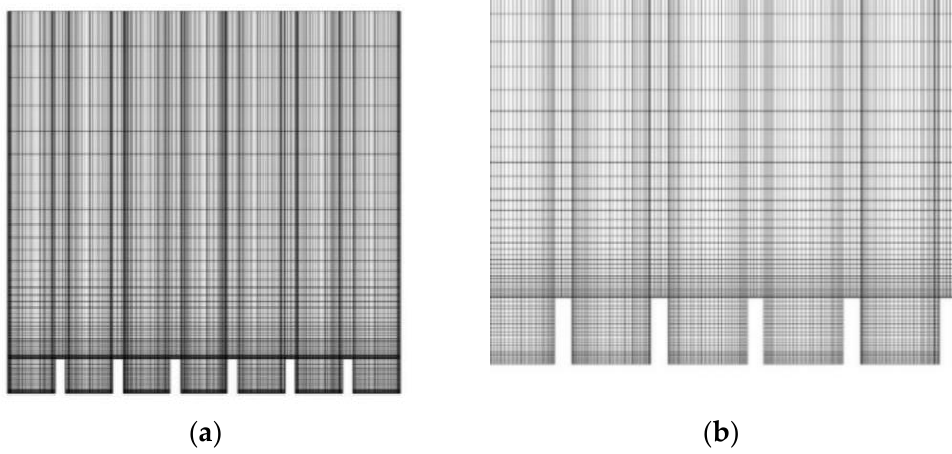
Figure 7. The meshing of rectangular groove plate. ( a ) rectangular grooves compute grids; ( b ) Rec- tangular groove internal grids.